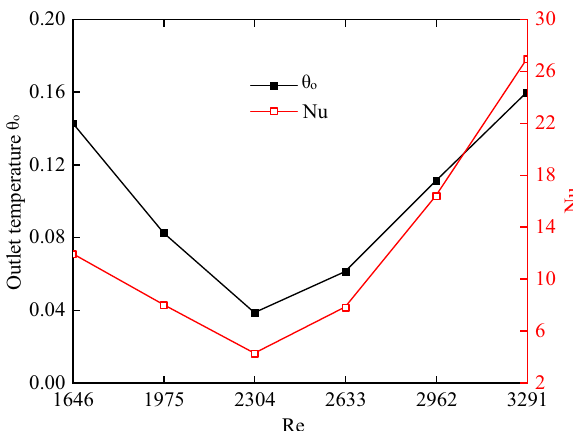
Fig. 8 Variation of average outlet water temperature and Nu with Re in forward flow mode